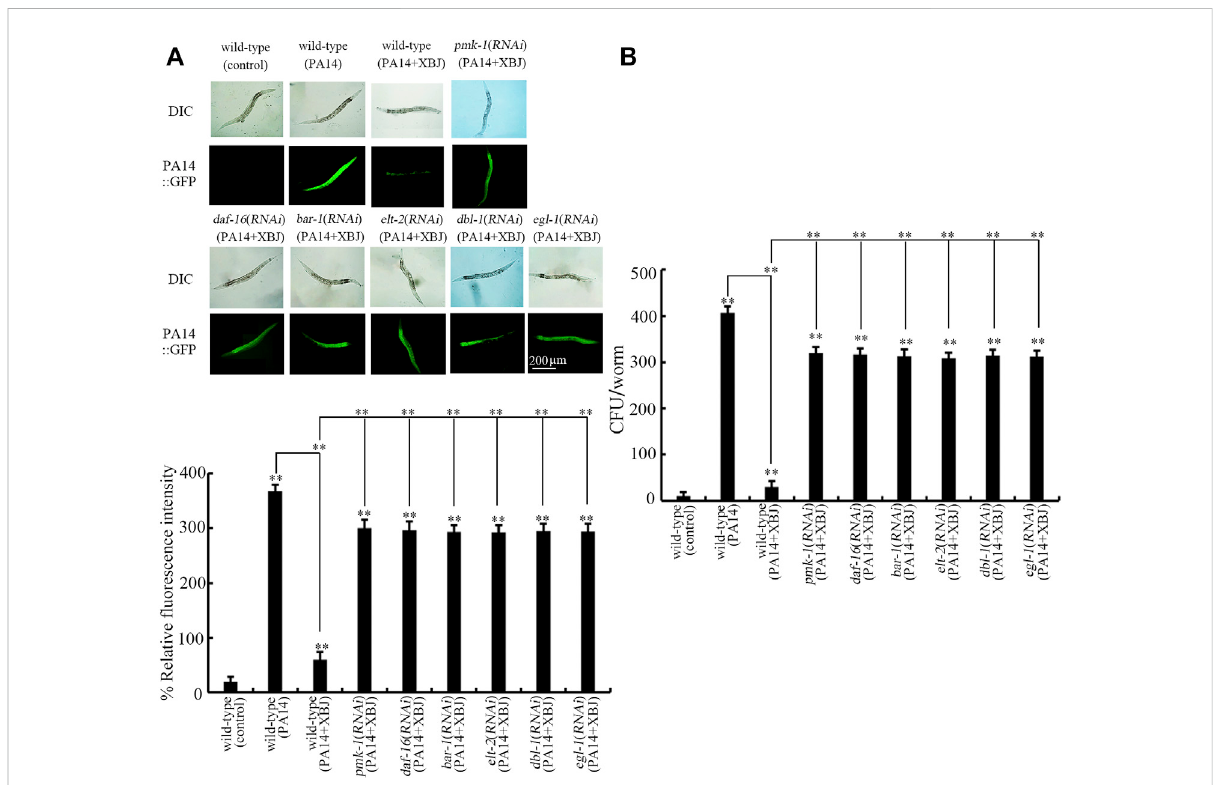
FIGURE 7 RNAi of bar-1 , elt-2 , pmk-1 , dbl-1 , egl-1 , and daf-16 affected the bene fi cial effect of Xuebijing (100%) treatment to reduce PA14:GFP (A) and to inhibit CFU (B) in P . aeruginosa -infected nematodes. RNAi was performed after P . aeruginosa infection. XBJ, Xuebijing. ** p < 0.01 vs. wild-type (control) (if not specially